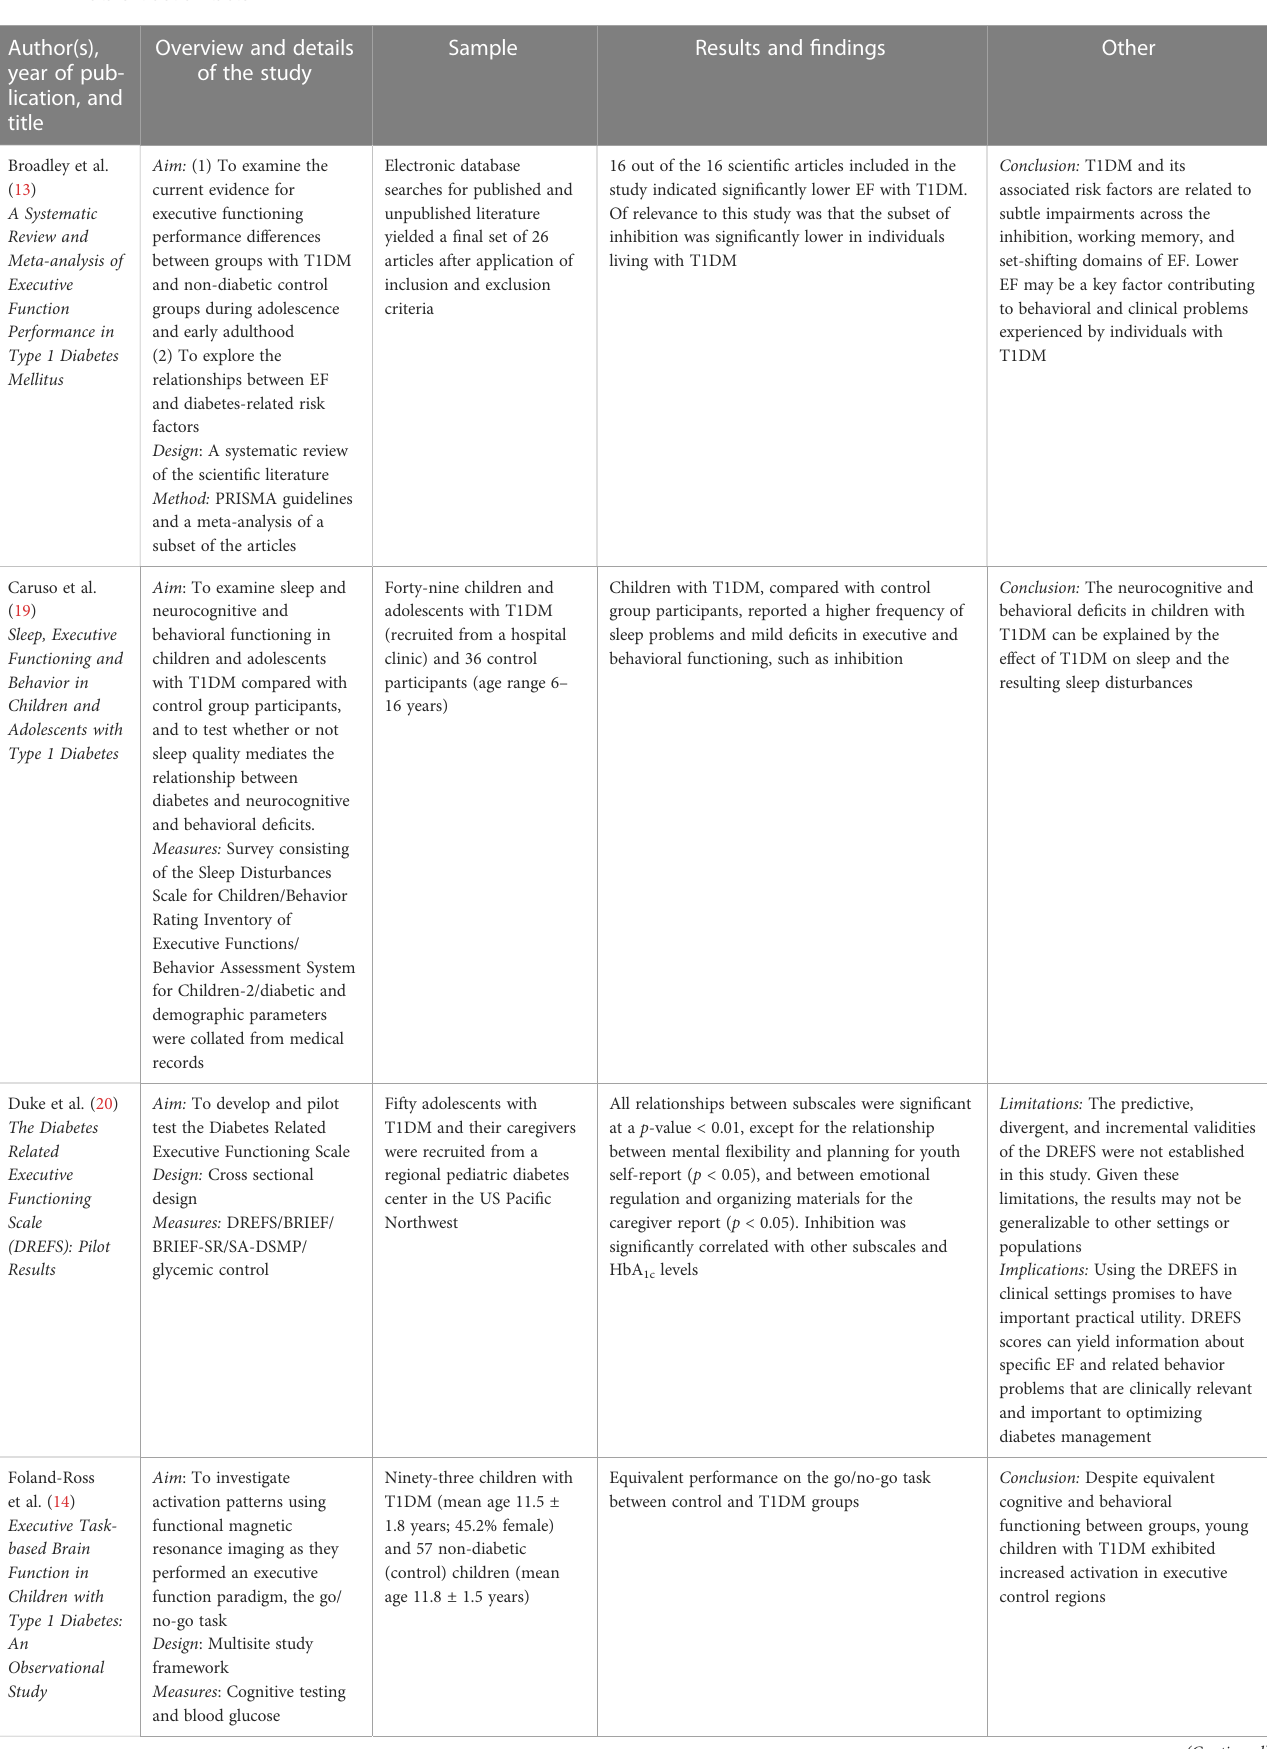
TABLE 1 Data extraction